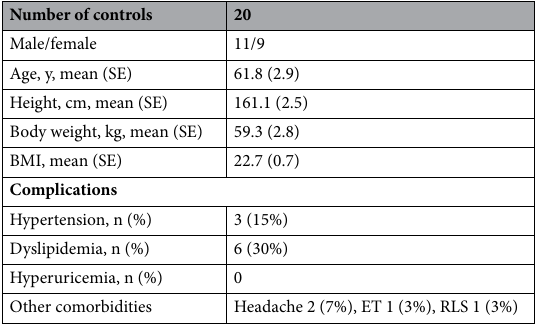
Table 1. Characteristics of control subjects (n = 20). SE standard error, BMI body mass index, ET essential tremor, RLS restless legs syndrome.